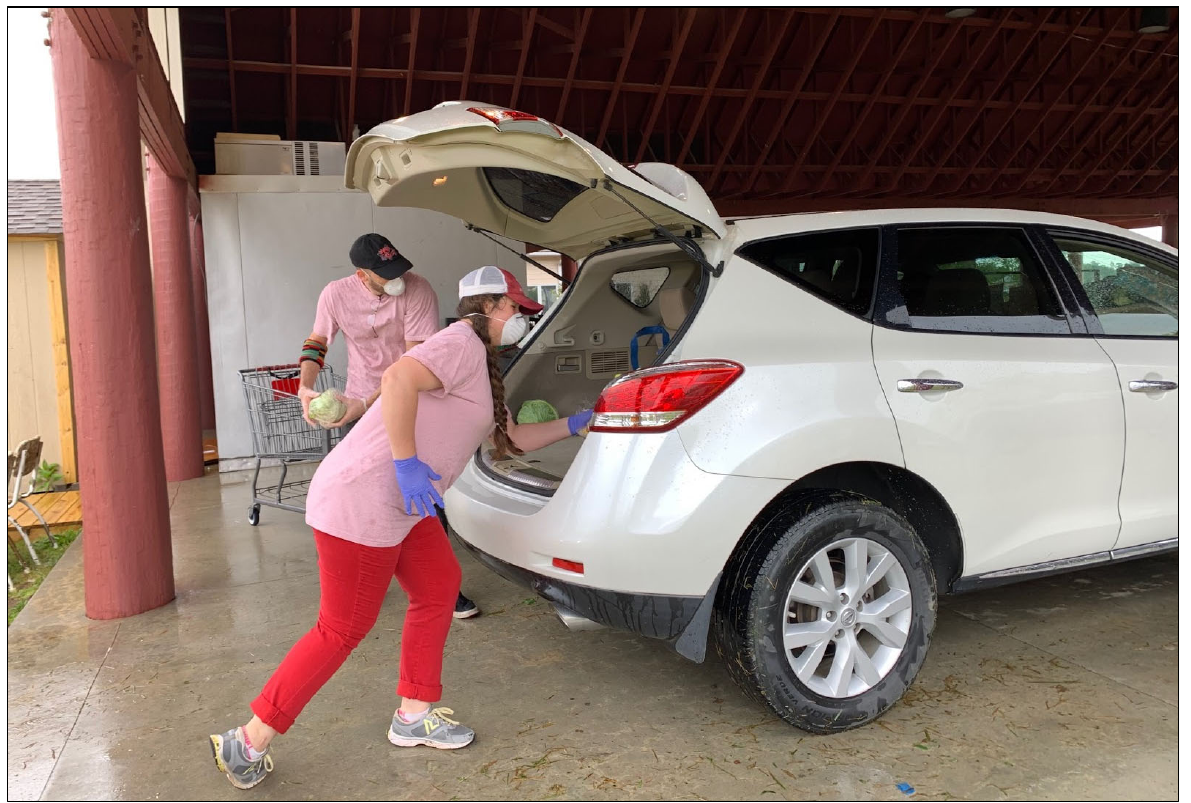
Photo courtesy of Episcopal Farmworker